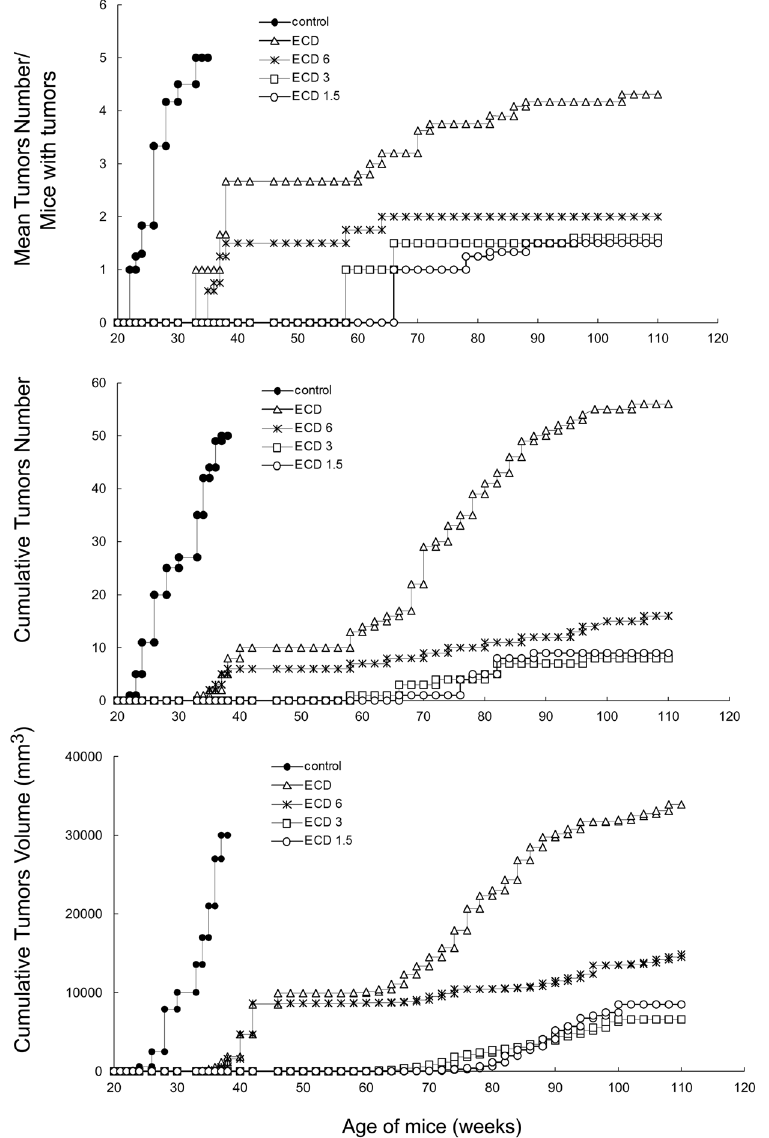
representative of one of two independent experiments. Statistically significance is reported in the